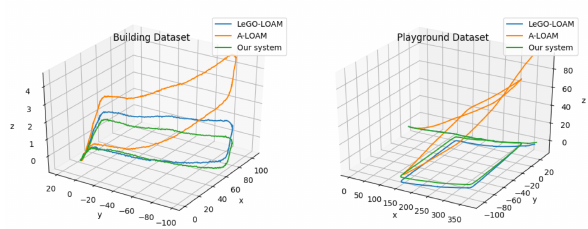
Figure 6. Trajectory